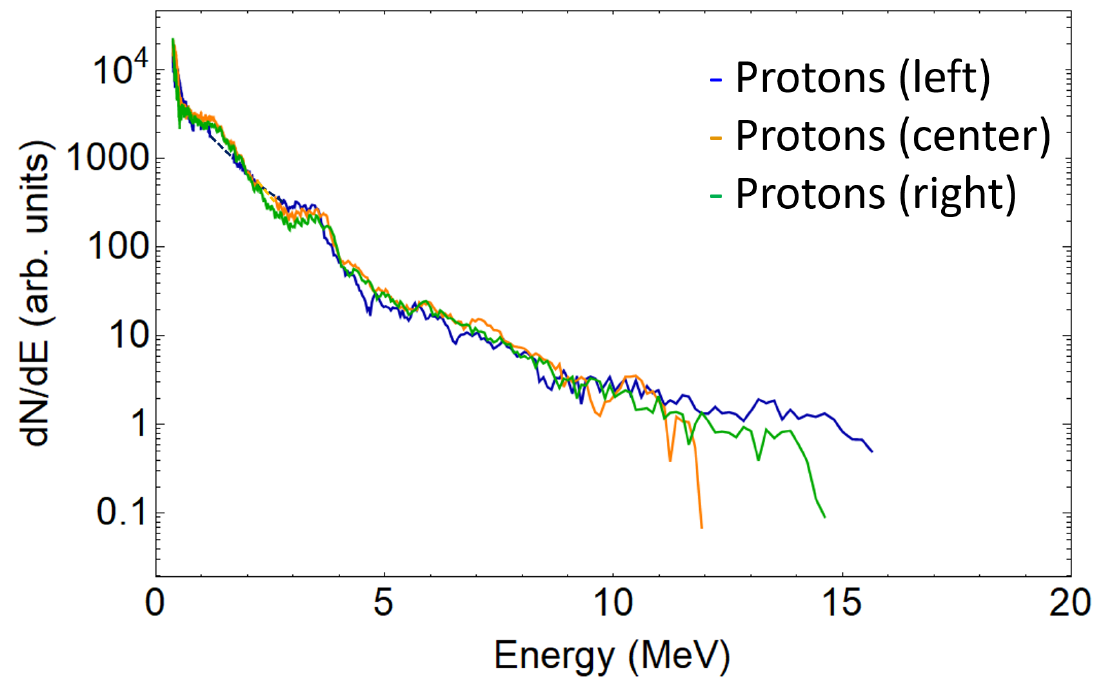
Figure 5. Left, center, and right proton beamlets spectra in the logarithmic scale. Dashed lines show the reconstructed spectrum range. It is important to note that the crosstalk between traces lays at different energy locations for each beamlet. This effect is clear from Figure 3; the relative horizontal position of each proton trace makes the crosses appear at different energetic levels. Note for instance that the proton right trace does not suffer any crosstalk; thus, no correction is applied.